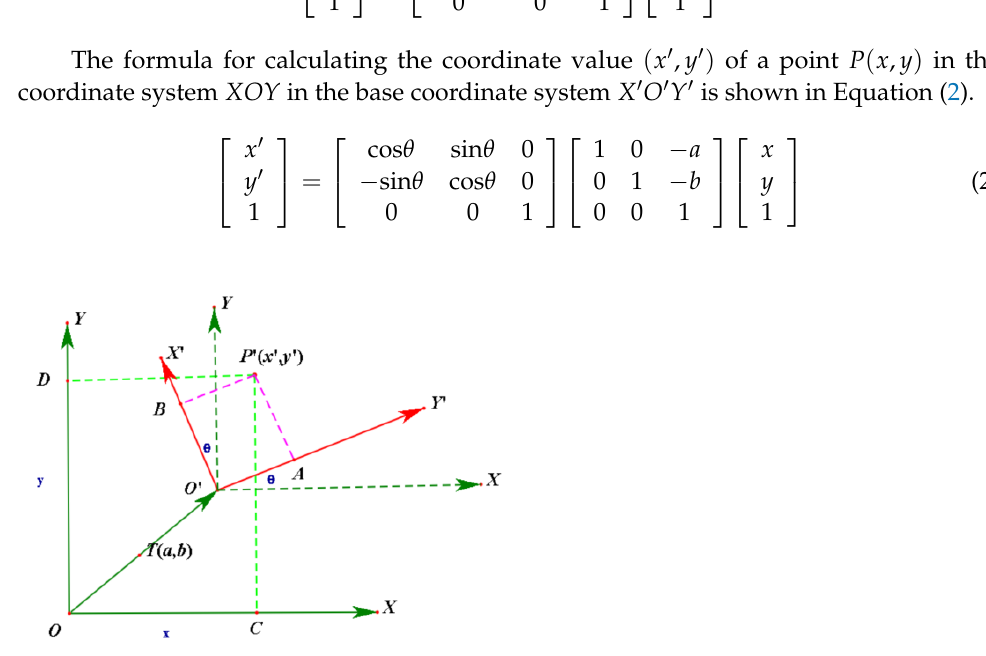
Figure 5. Two-dimensional coordinate system